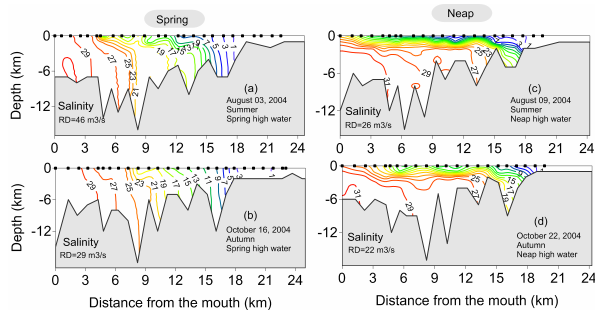
Fig. 4. Salinity distributions for all longitudinal depth surveys of the Sumjin River Estuary at high water during spring (a, b) and neap (c, d) tides during summer and autumn of 2004. The black solid circles indicate the CTD stations.